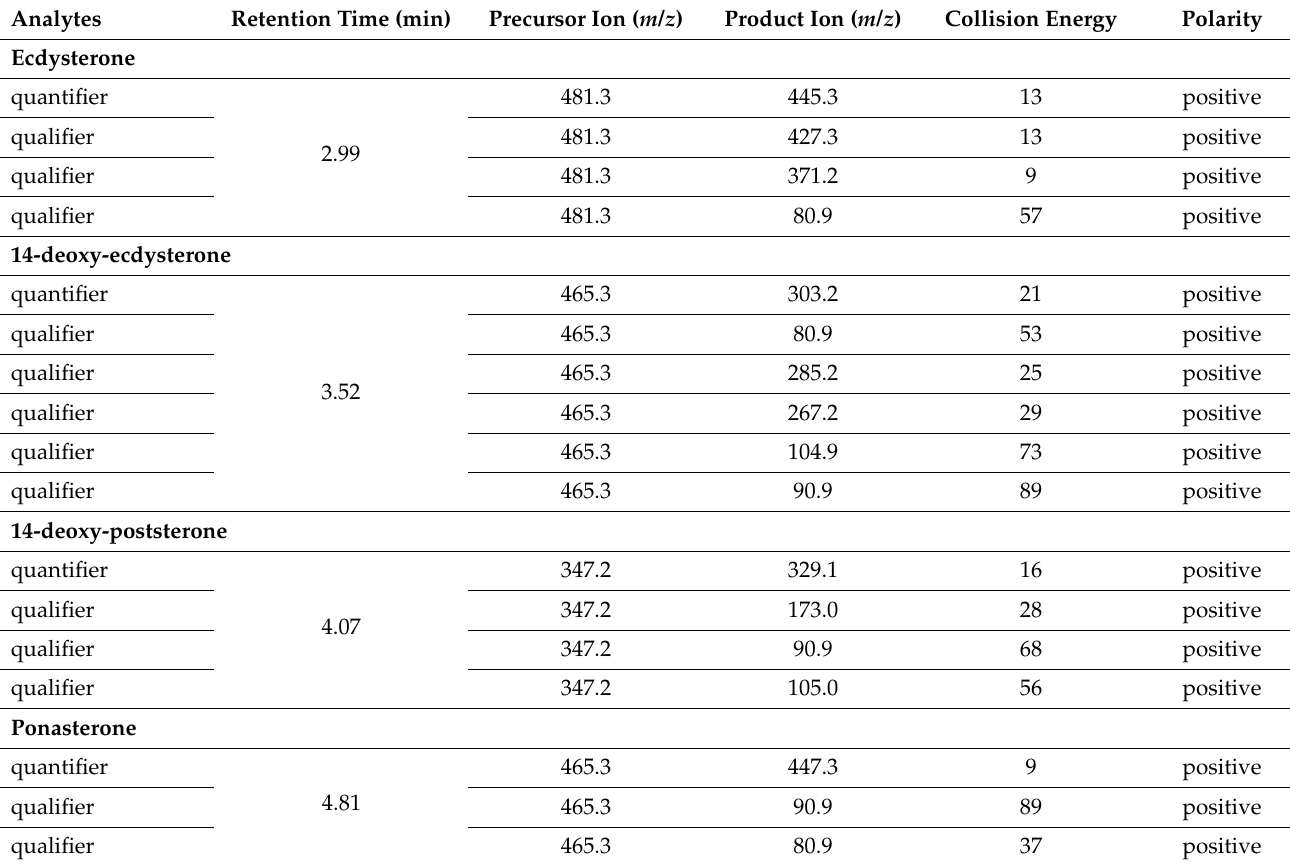
Table 7. Mass spectrometric parameters for MRM transitions for ecdysterone, its metabolites, and the